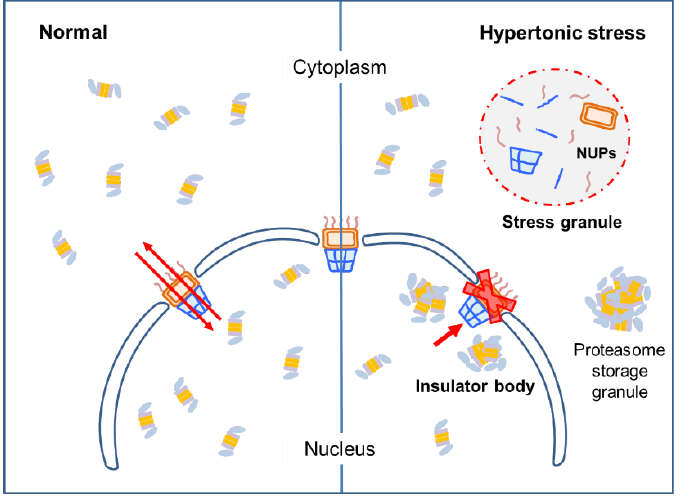
Figure 4. Proposed model for nuclear proteasome foci formation. Unstressed cells freely translocate 26S proteasomes from the nucleus to cytosol and vice versa through NPCs. However, cells under hyperosmotic environments appear to lose this normal transport function potentially through the sequestration of NPC components into stress granules. Both nucleoplasmic proteasome foci and cytoplasmic stress granules are membraneless organelles formed through LLPS or demixing among intact 26S proteasome holoenzymes and their substrates. Whether hyperosmotic stress leads to the formation of cytoplasmic proteasome body, such as proteasome storage granules, remains to be identified.